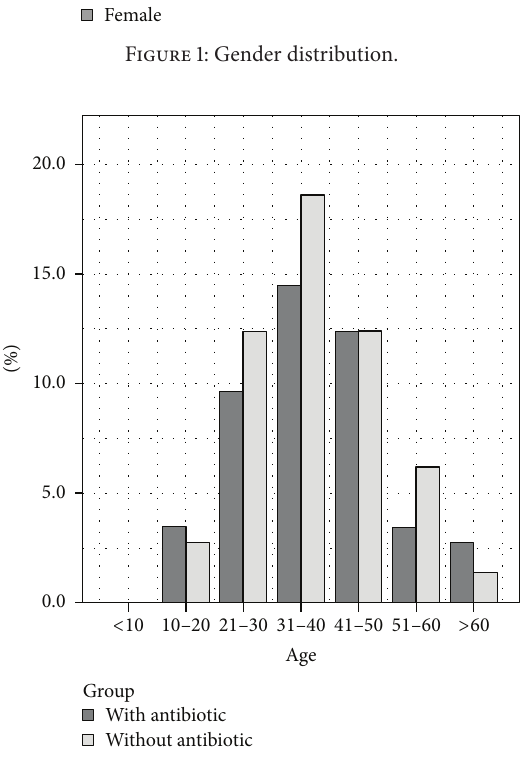
Figure 2: Age distribution.